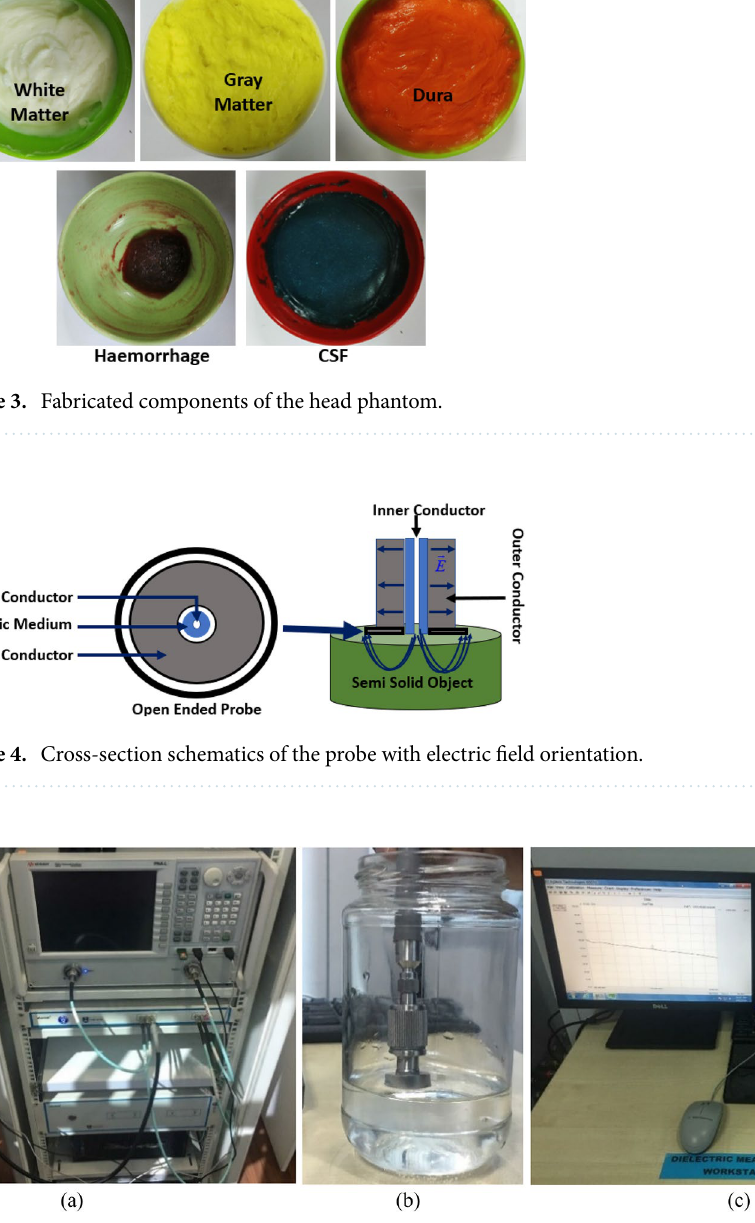
Figure 5. ( a ) Measurement setup with VNA ( b ) open-ended coaxial probe ( c ) calibration with sterile